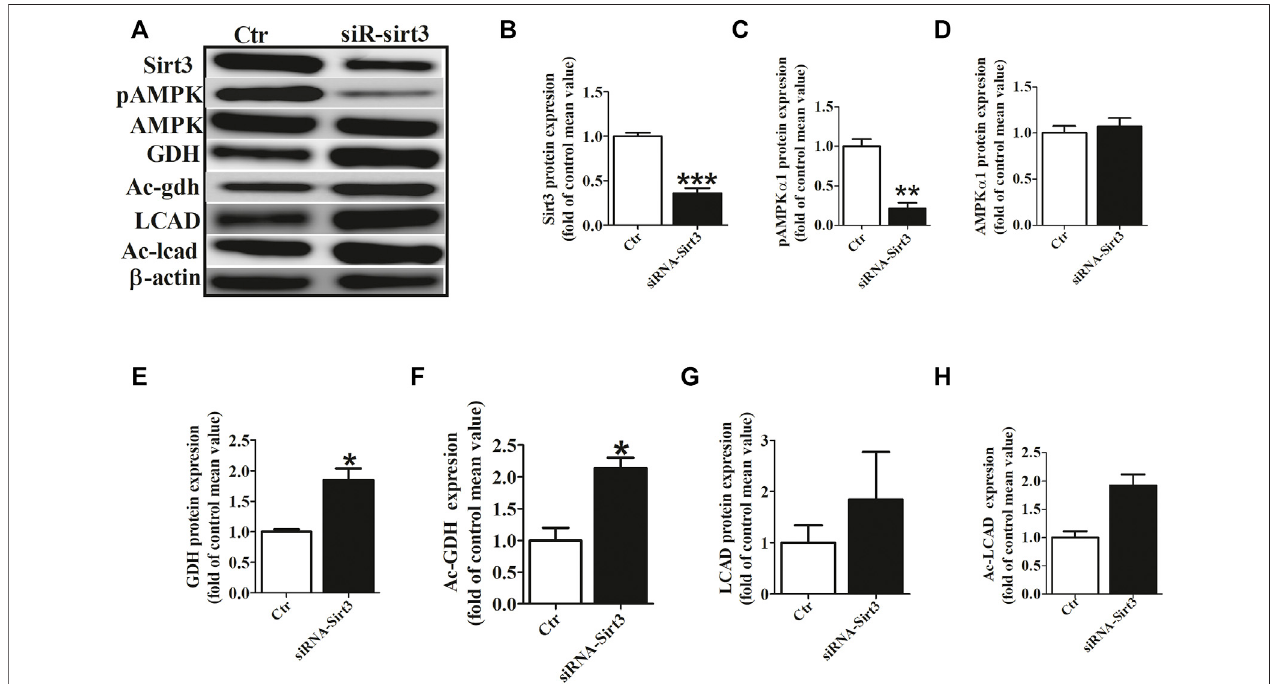
FIGURE 5 | Sirt3 siRNA up-regulated the acetylation level of metabolic enzymes. (A) Representative bands of Sirt3, pho-AMPK α 1, AMPK α 1, GDH, Ac-GDH (Ac- gdh), LCAD and Ac-LCAD expression. (B) Statistical results for Sirt3 expression. (C,D) Statistical results for pho-AMPK α 1and AMPK α 1 expression. (E,F) Statistical results for GDH and Ac-GDH expression. (G,H) Statistical results for LCAD and Ac-LCAD expression. * p < 0.05 vs. control group, ** p < 0.05 vs. control group, *** p < 0.05 vs. control group, n = 3 each